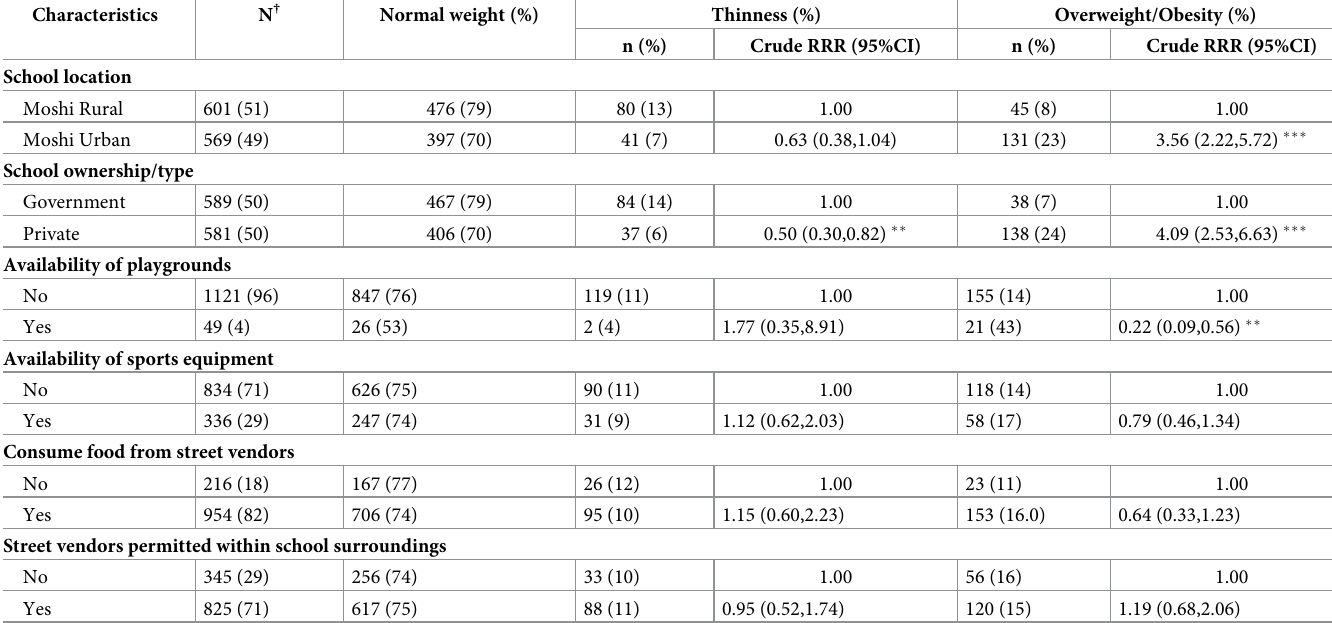
Table 4. School level correlates for overweight and obesity (N = 1170).